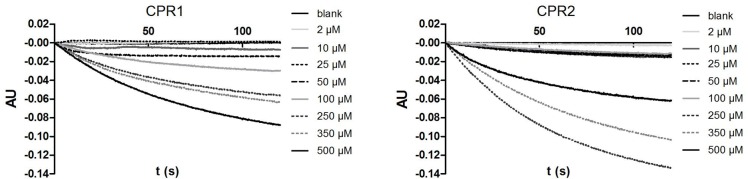
Standard plots for determining ferricyanide reduction kinetics catalyzed by GsCPR1 or GsCPR2 in the presence of NADPH.The CPR-catalyzed reduction of ferricyanide in concentrations between 2 μM and 500 μM at 420 nm in the presence of saturating 100 mM NADPH in 100 mM potassium phosphate (pH 7.6). Different concentrations of ferricyanide are represented in shades of grey and dashed lines. Decreasing absorbance at 420 nm, quantifying the reduction of ferricyanide to ferrocyanide, was plotted by normalizing all points relative to the point zero baseline.